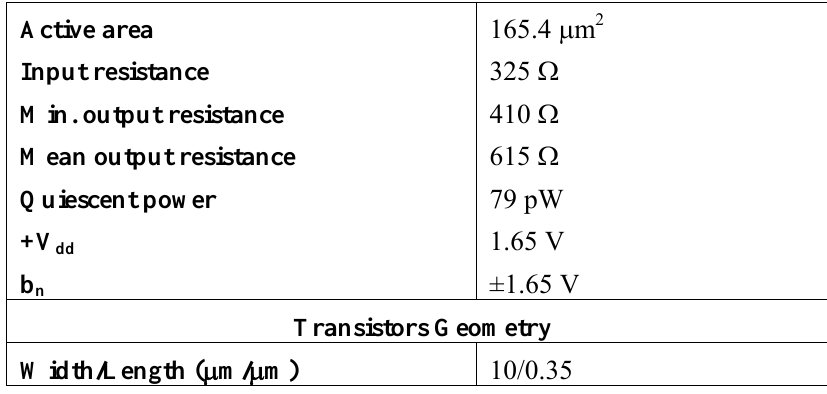
Table 2. Current ladder characteristics.